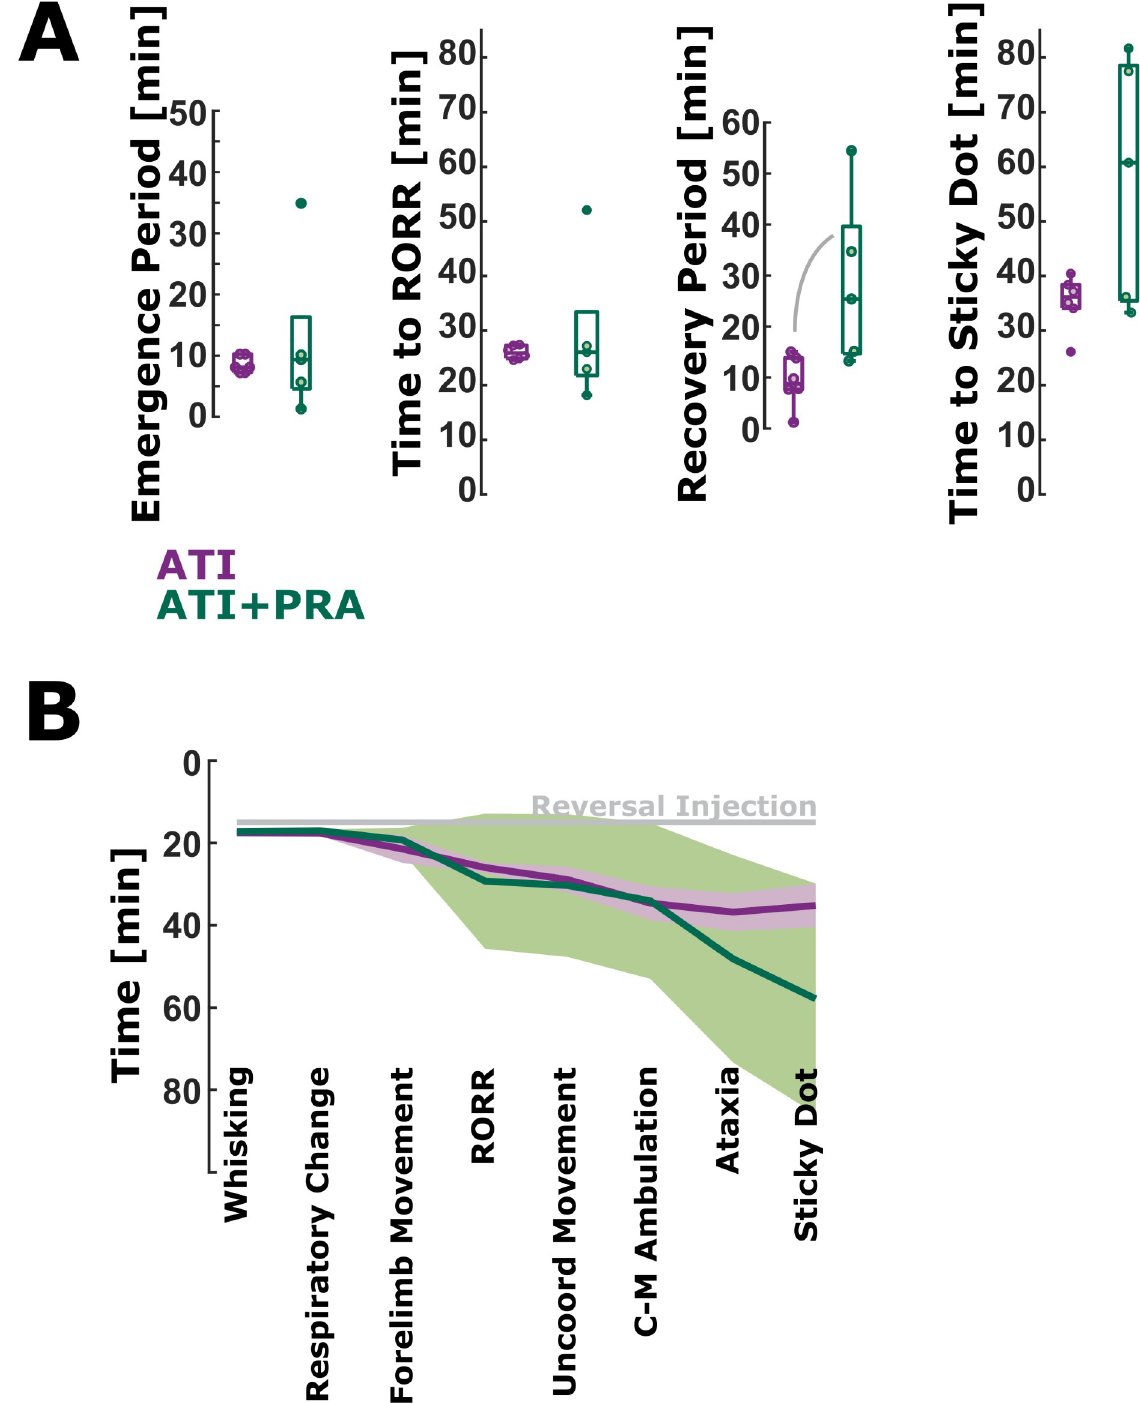
Fig 3. Latency to return of righting reflex (RORR) and sticky dot notice and the emergence and recovery period duration for the atipamezole (ATI) and ATI+PRA (prazosin) group. A) There were no significant differences between the ATI and ATI+PRA group in the latency to RORR and sticky dot notice. There was no difference in the duration of the emergence period as well. The recovery period was significantly shorter for ATI than for ATI+PRA. The solid, gray lines indicate significant differences between groups. B) Time course of the durations to the different emergence and recovery markers. The solid lines present the mean and the 95% confidence interval on the mean. The gray line indicates time of reversal injection, 15 minutes post-ketamine/xylazine injection.